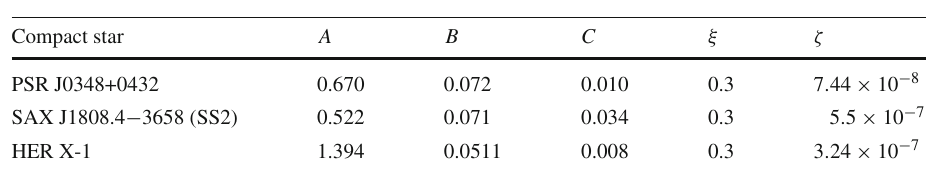
Chaplygin EoS for α (cid:5)= 0 ( β = 1, β 1 = 0 and γ = 1)